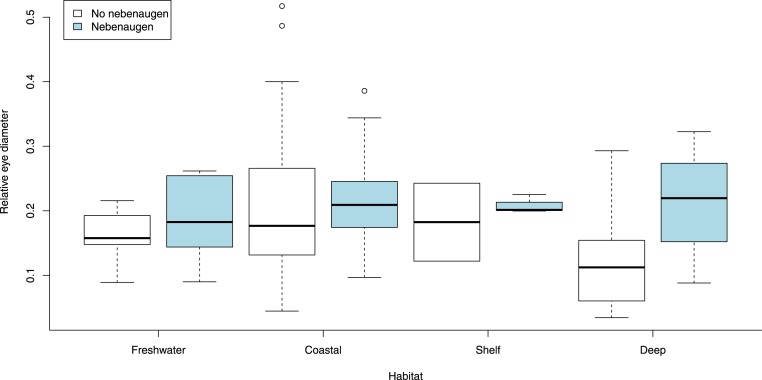
Eye diameter and depth.Relative eye diameters of animals from freshwater and three marine depth ranges depending on presence/absence of nebeaugen. Depths are Coastal 0–100 m, Shelf 101–300 m, Deep, >300 m.